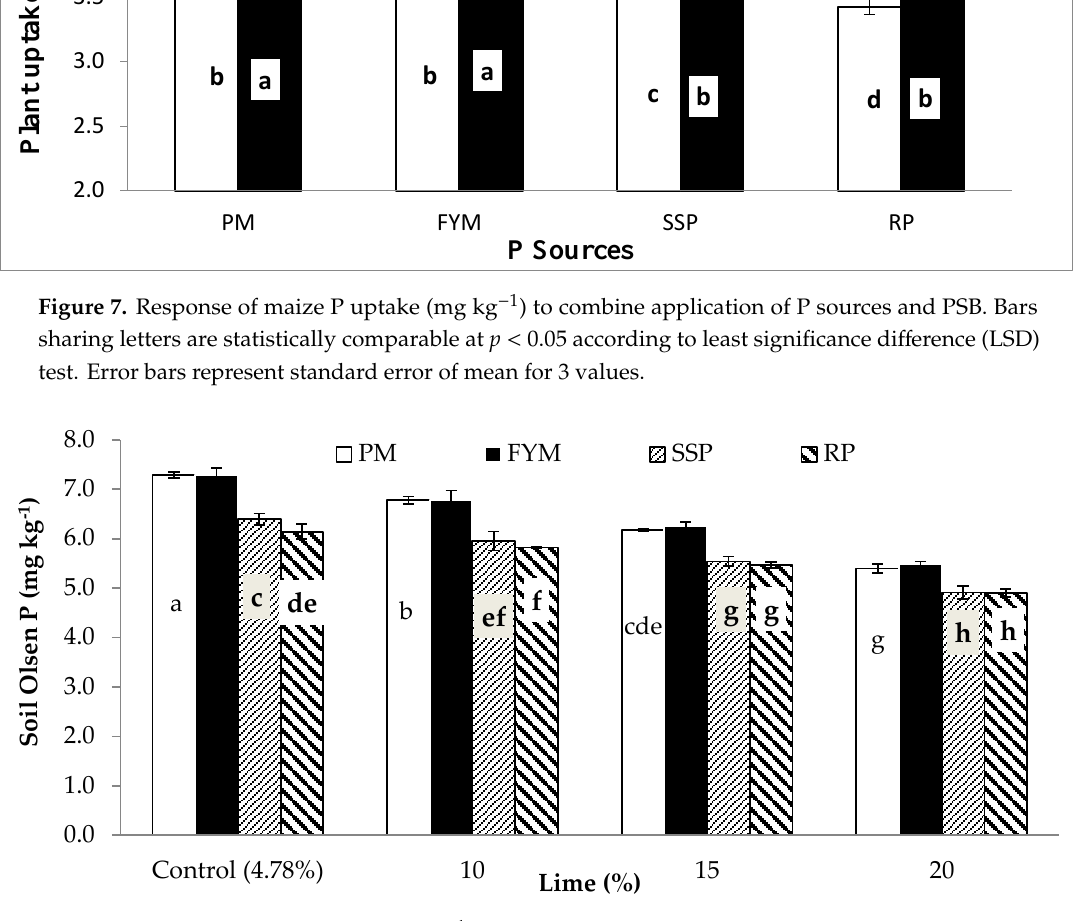
Figure 8. Postharvest soil Olsen P (mg kg −1 ) as affected by P sources and lime. Bars sharing letters are statistically comparable at p < 0.05 according to least significance difference (LSD) test. Error bars show standard error (n = 3). Table 6. Postharvest soil Olsen P, electrical conductivity (EC) and lime content as affected by phosphate-solubilizing bacteria (PSB), phosphorus sources under varying lime.